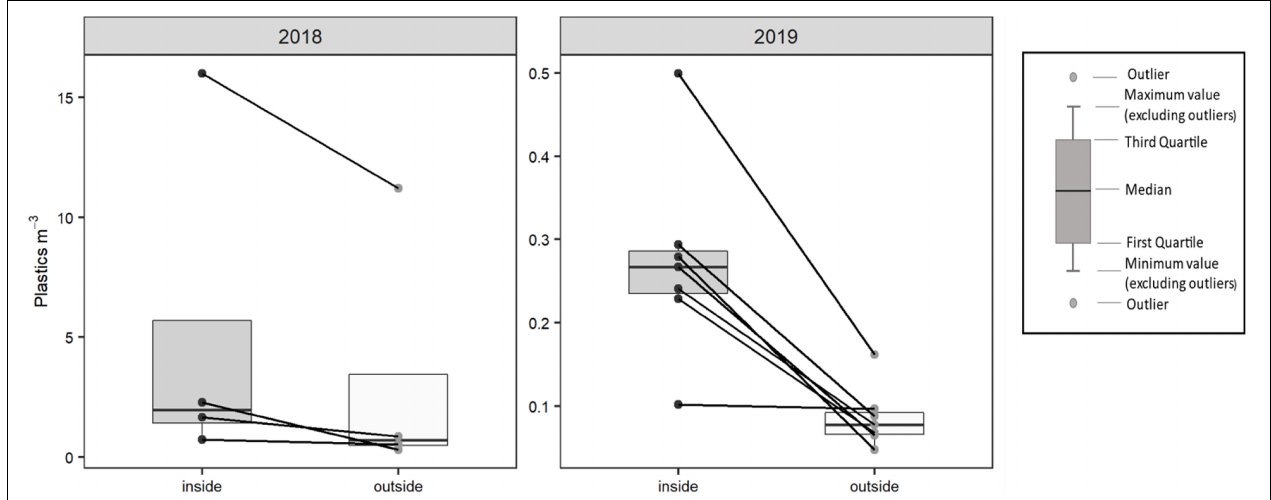
FIGURE 4 | Density of microplastics (plastics/m 3 ) inside and outside the slicks. The lines represent pairs of slicks, (2018) n = 4 pairs of slicks, and (2019) n = 7 pairs. Note that the scale is different between 2018 and 2019.